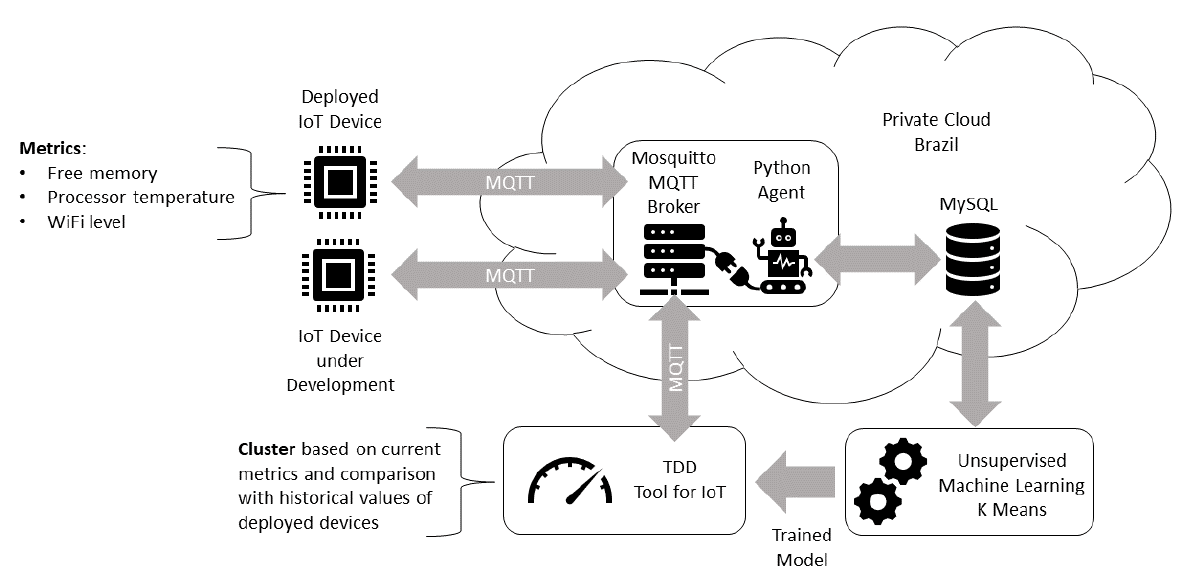
Figure 7. Remote lab study case